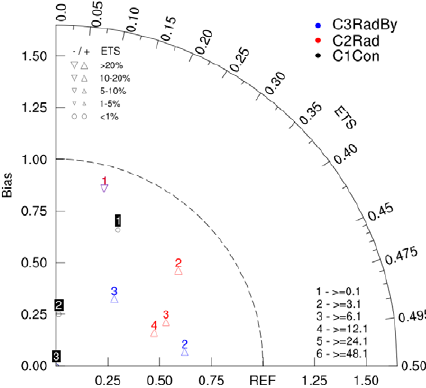
Figure 14. Hourly accumulated precipitation of ( a ) C1Con, ( b ) C1Rad, and ( c ) C3RadBy at 0900 UTC. The colored dots show the locations and hourly accumulated precipitation (in millimeters) of observations of SYNOP. The Forecast hourly accumulated precipitation (unit mm) is represented by the colour shades.